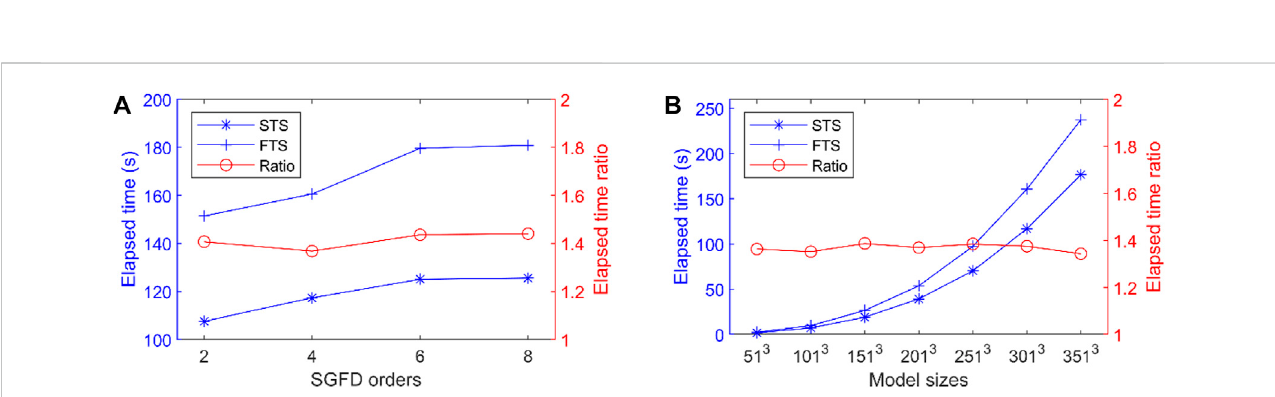
FIGURE 9 Ef fi ciency comparisons oftheSTS andFTS method (A) with theincreaseofSGFD orders and (B) with theincrease ofmodelsizes. The model size is301× 301 ×301 in (A) , and the fourth-order spatial accuracy is used in and (B) . In (A) and (B) , the left axis represents the time consumption and the right axis represents the time consumption ratio of FTS to